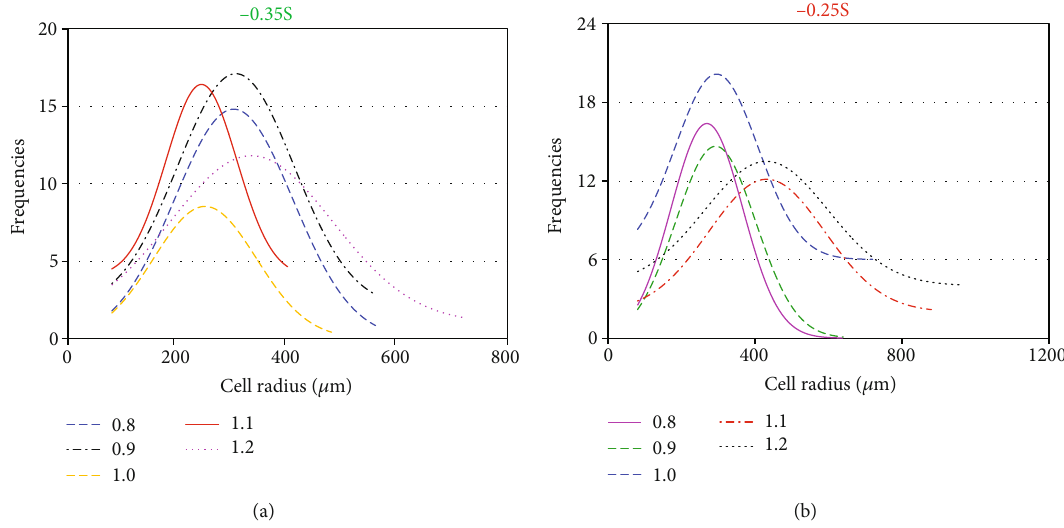
Figure 8: Dependence of the pore size distribution on the NCO/OH molar